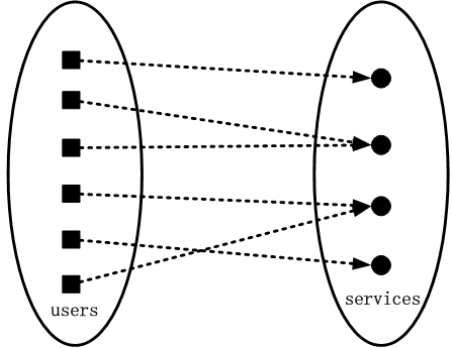
Figure 1. Privacy preservation by k-anonymity and l